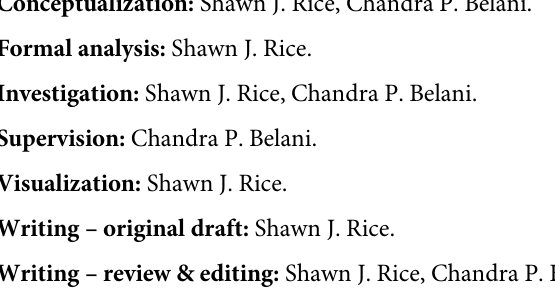
S1 Table. Summary of selected articles evaluating systemic inflammation (SI) markers in lung cancer. S2 Table. Summary of patient characteristics who were included in the study. S3 Table. Summary of SI markers and classification in the different patient groups. S4 Table. Median progression-free survival for SI markers based on Kaplan-Meier analysis. S5 Table. Progression-free (PFS) and overall (OS) survival effects of individual cytokines for NSCLC and SCLC with p-values adjusted using the Benjamini-Hochberg method. S6 Table. Kruskal-Wallis test results comparing each plasma factor between the four IL-6/ NLR groups with multi-sample adjustment using Benjamini-Hochberg